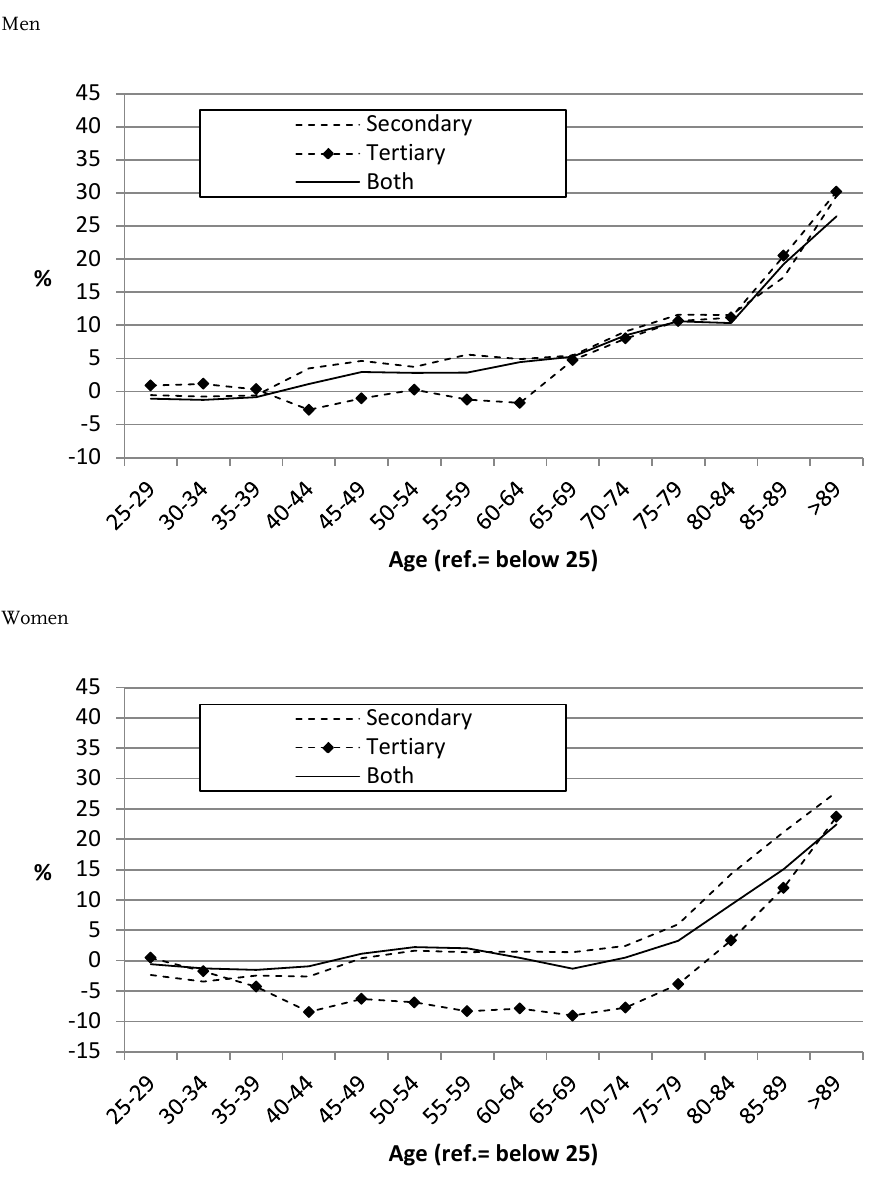
Figure A.1 : Age-effects on absence of secondary-sphere contacts (disconnectedness from friends and relatives) and absence of tertiary-sphere contacts (non-participation in clubs and civil